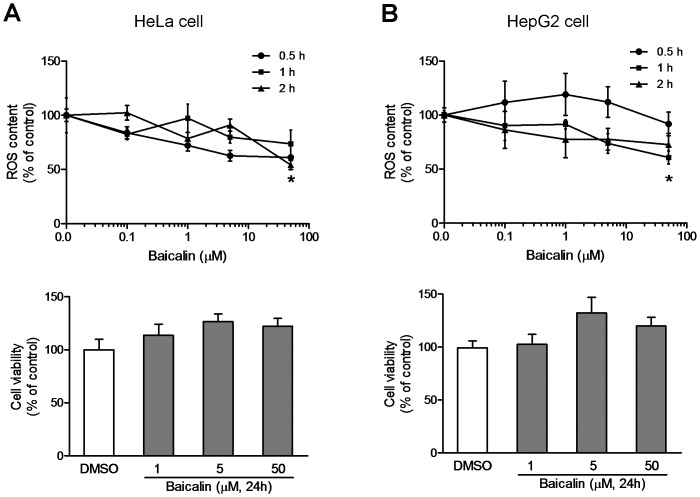
Effects of baicalin on ROS and ATP production.HeLa (A) and HepG2 (B) cells were exposed to various concentrations of baicalin for indicated times. Intracellular ROS production quantified using the fluorescent probe DCFDA (top), and the cell viability was determined by MTT test (bottom). Data were expressed as mean ± SE relative to vehicle control from at least four independent experiments. * p<0.05 compared to vehicle control.